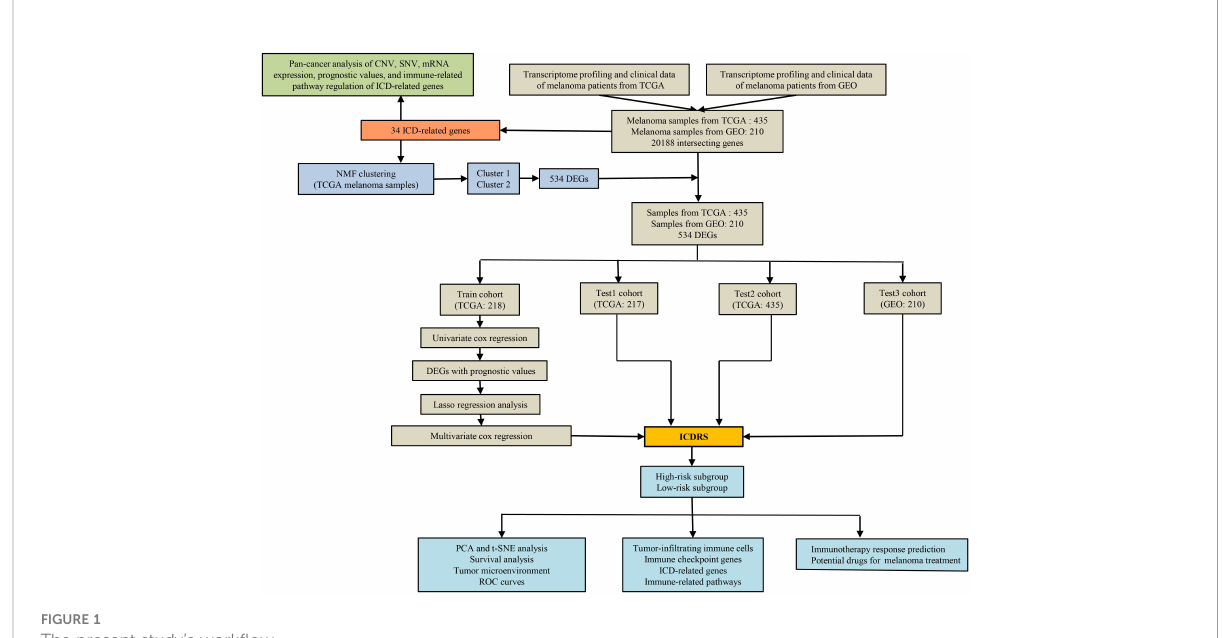
FIGURE 1 The present study ’ s work fl